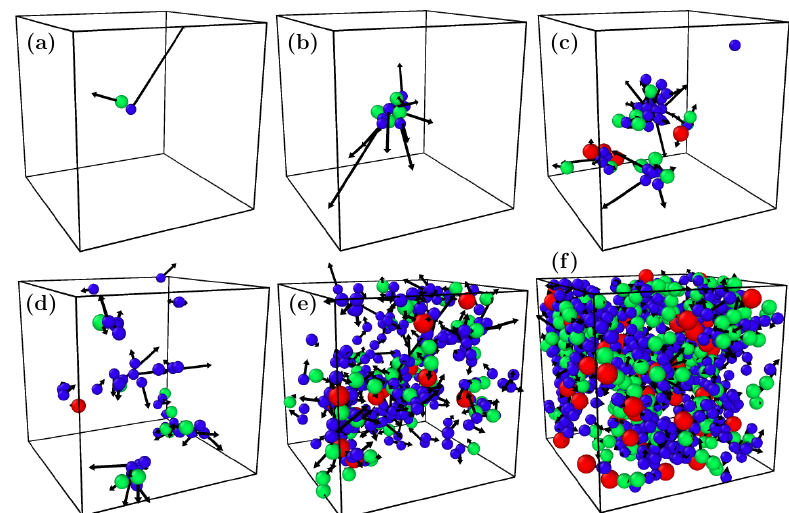
Figure 2: The unstable modes of a saddle at T = 0.45. We show (cid:100) P ( λ α ) (cid:101) particles with the largest norms shown by black arrows. The particle with the largest norm is placed at the center in each box. Different colors indicate different particle